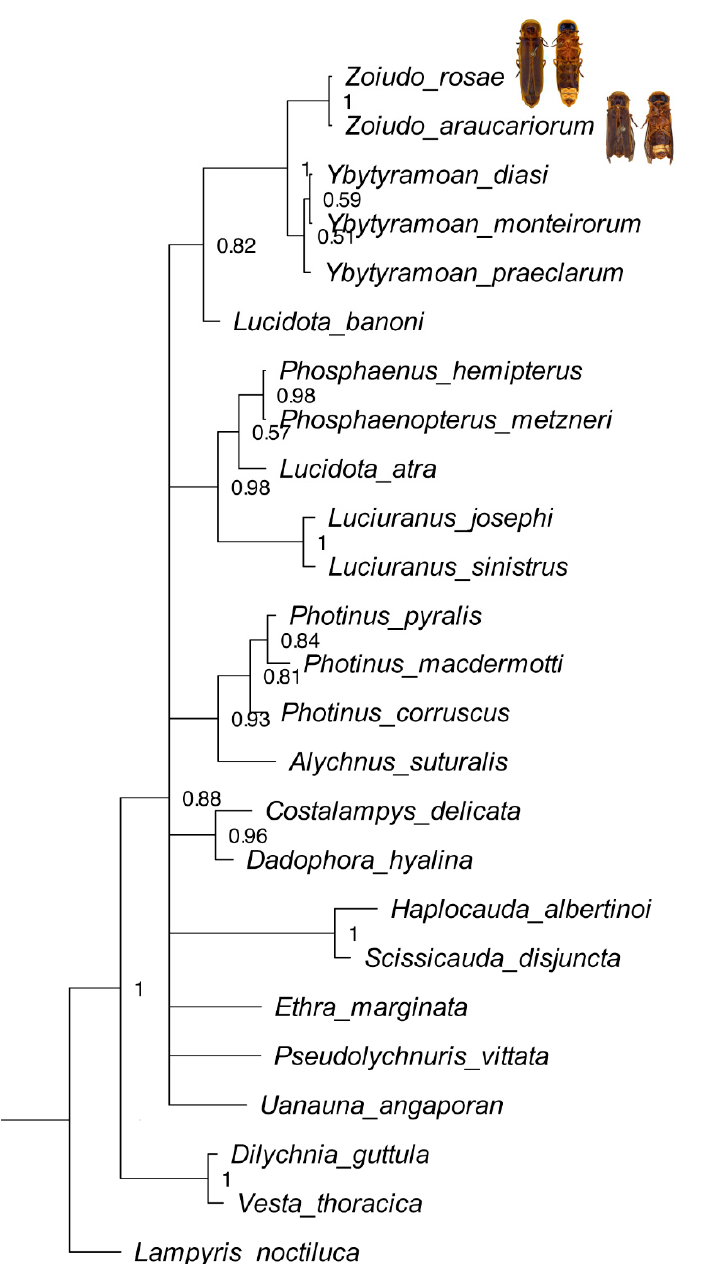
Figure 1. Majority rule Bayesian consensus tree of 97 morphological characters of 25 taxa, with dorsal habiti of the two new Zoiudo species plotted after their names.